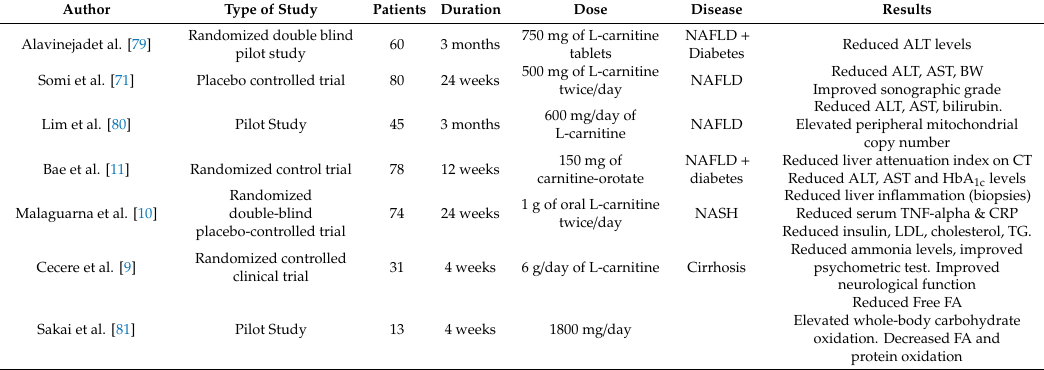
Table 1. Research studies in humans. E ff ects of L-carnitine supplementation in liver disease. Most results are undertaken in blood samples unless otherwise stated. ALT = alanine aminotransferase, AST = aspartate transaminase, BW = body weight, CRP = C-Reactive Protein, CT = Computed Tomography, FA = fatty acids, HbA 1c = glycated hemoglobin, TNF = Tumor Necrosis Factor, LDL = low-density